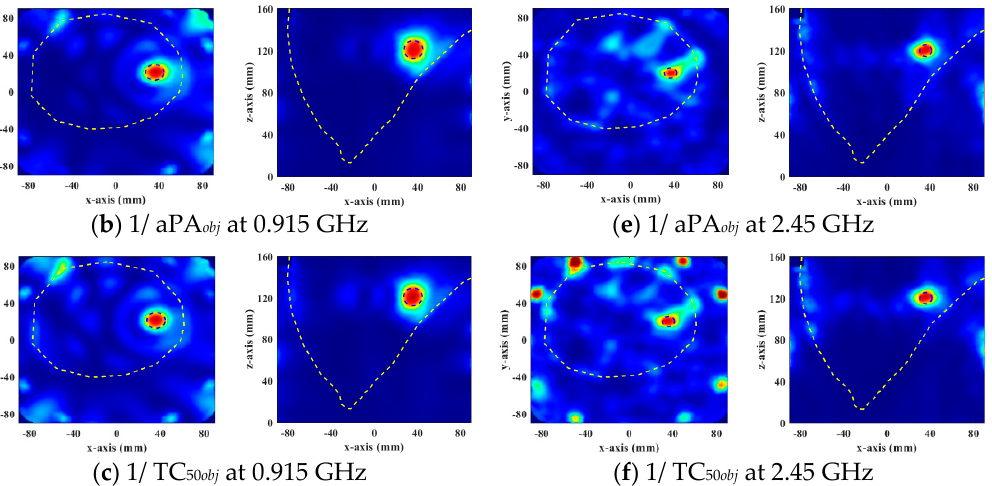
Figure 7. Normalized SAR distribution in axial (XY) and coronal (XZ) planes of a heterogeneous breast model optimized by each objective function used in DE.